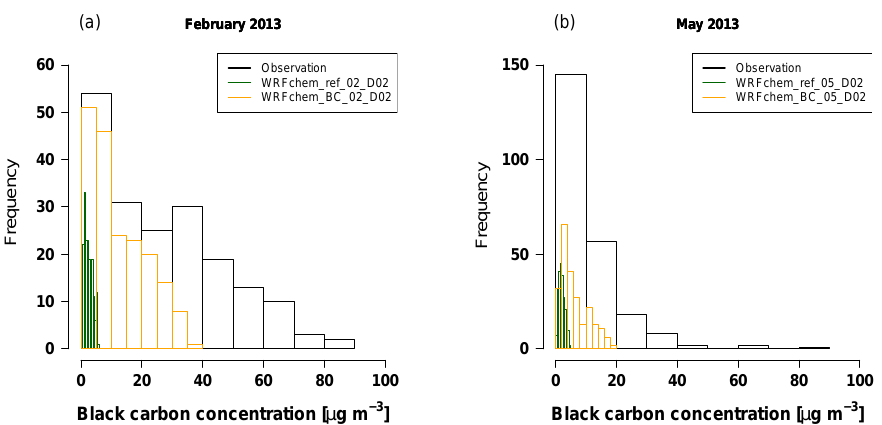
Figure 14. Black carbon concentrations at the Bode site, measured and simulated with WRF-Chem for February 2013 WR- Fchem_ref_02/05_D02 (a) and for May 2013 WRFchem_ref_02/05_D02 (b) as a histogram calculated from the 3h